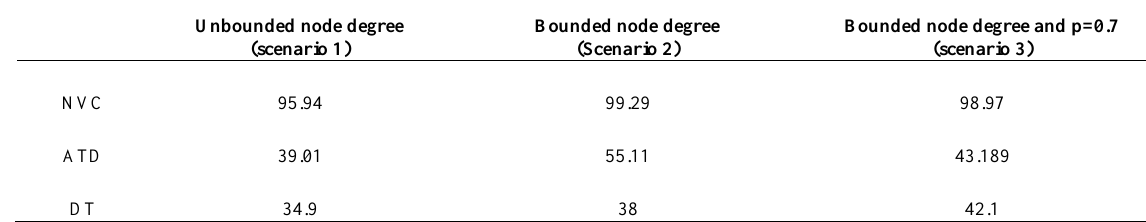
Table 5. Average of NVC, ATD and DT for 3 scenario.